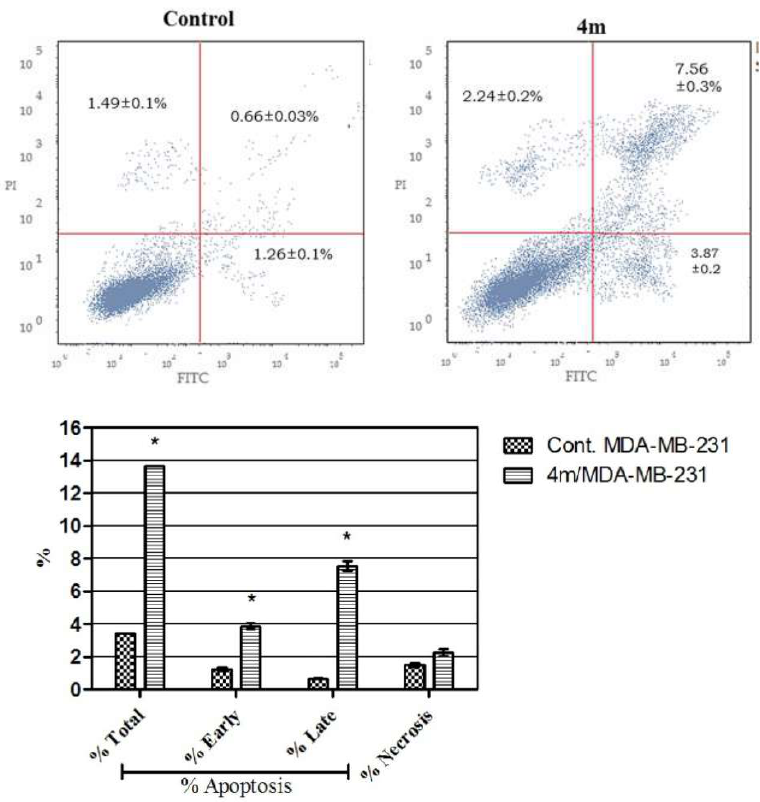
Figure 5. Effect of compound 4m on the percentage of annexin V-FITC-positive staining in MDA-MB-231 cells. The experiments were done in triplicates. The four quadrants identified as: LL , viable; LR , early apoptotic; UR , late apoptotic; UL , necrotic. * Significantly different from control at p < 0.05. (One-way ANOVA test).